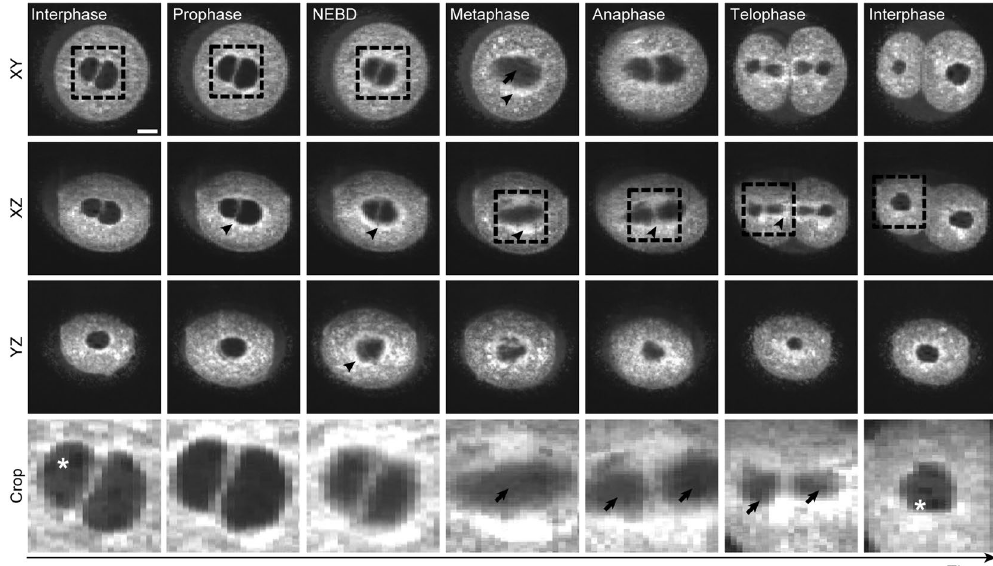
Figure 6. The first embryonic division visualized by OCM. Mouse zygotes were subjected to OCM time-lapse imaging DTIsp #5 protocol for 13.5 hrs with 120 s intervals between the acquisition of each 3D dataset. Panels present OCM minimum intensity projections of 15 μ m thick slices (Procedure #2) selected from the time-lapse recording, showing main events during the first embryonic division: disappearance of nucleoli (in prophase), nuclear envelope break-down (NEBD), formation of the metaphase spindle (metaphase), segregation of chromosomes (anaphase, telophase) and formation of new nucleus with nucleoli (interphase - the last panel). Asterisks indicate the nucleoli, arrows - the microtubular parts of the spindle, arrowheads - a ring formed by membranous organelles (probably ER and mitochondria) around the nuclear apparatus and the spindle during the cell division. Cropped regions are encircled with a dashed line. Chromosomes are not visible with this type of spatial averaging. Scale bars represent 20 µ m. See also Supplementary Video S14 for more images of these